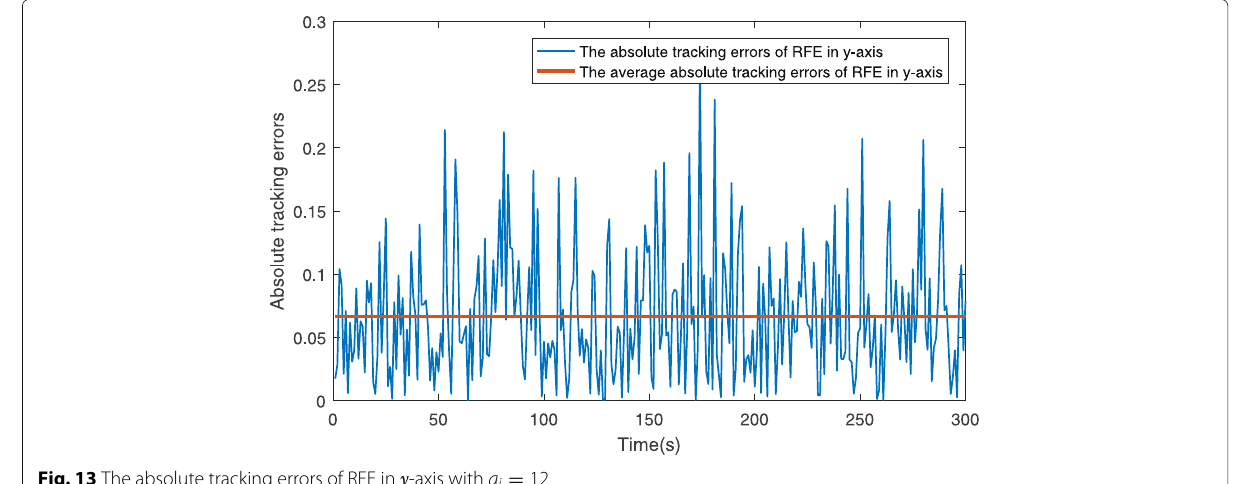
Fig. 13 The absolute tracking errors of RFE in y -axis with a i = 12